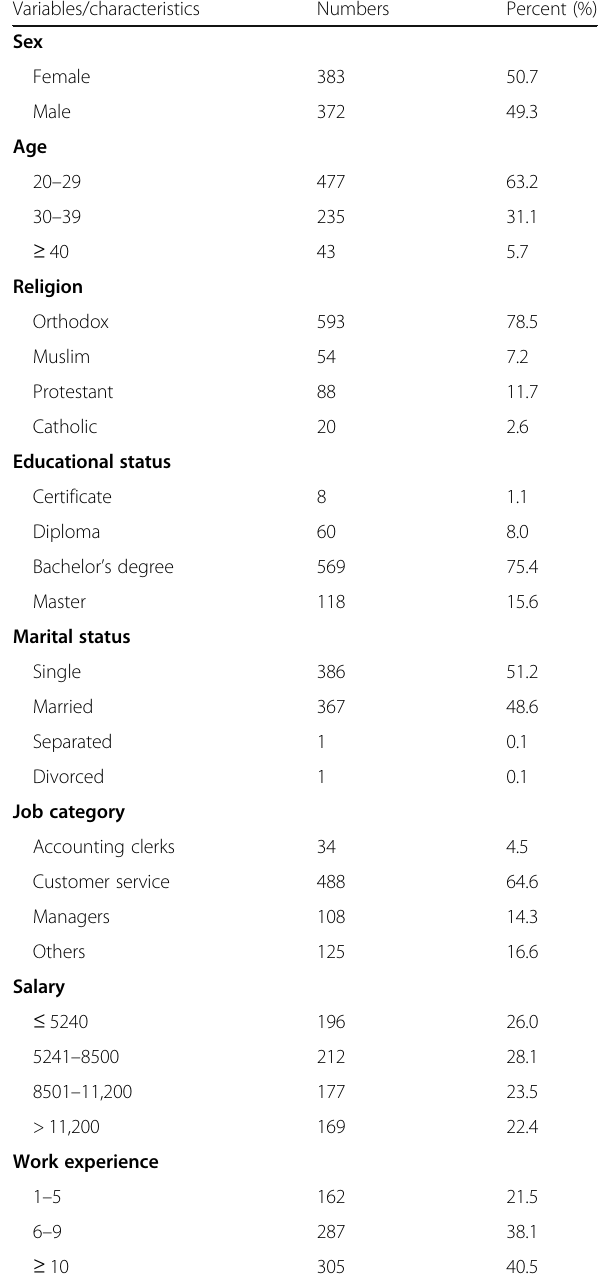
Table 1 Socio-demographic characteristics of bank